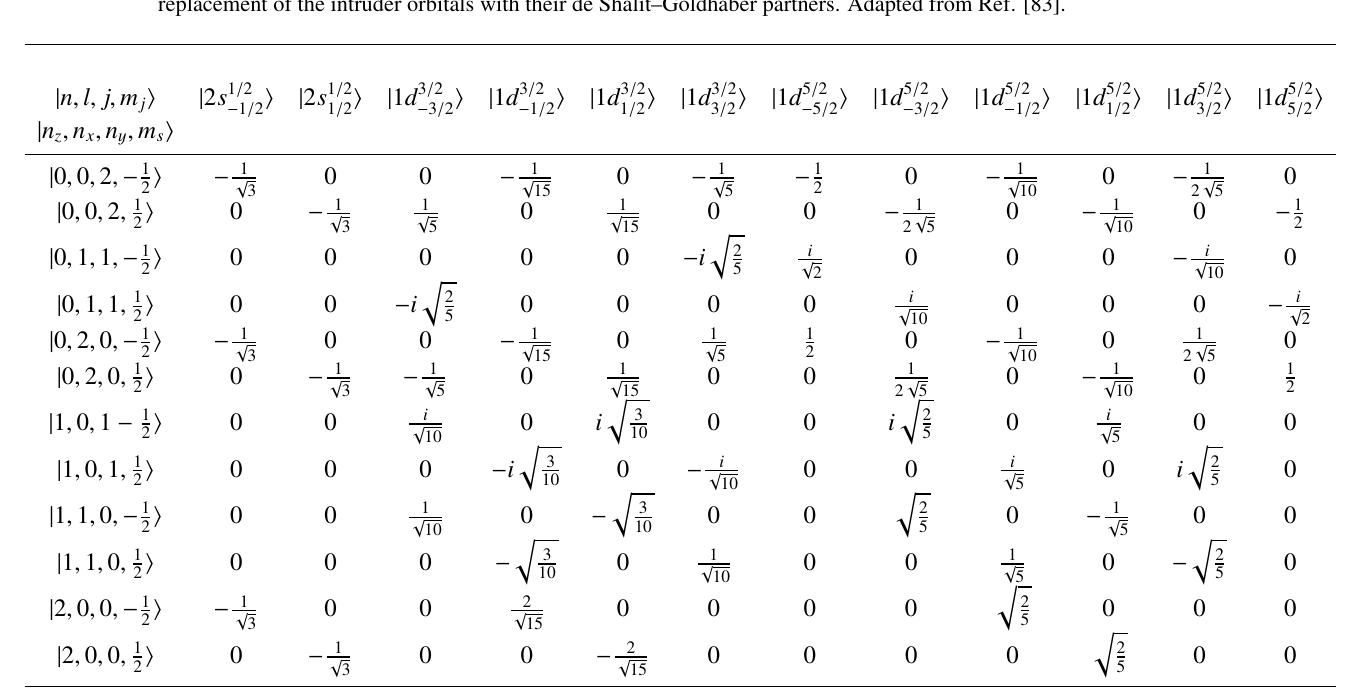
Table 2. The transformation matrix R · C for N = 2. The shell model orbitals appear in the first line, while the Elliott orbitals appear in the first column. These orbitals are used in the harmonic oscillator shell 8-20 ( sd shell), or in the proxy-SU(3) shell 14-26 after the replacement of the intruder orbitals with their de Shalit–Goldhaber partners. Adapted from Ref. [83].